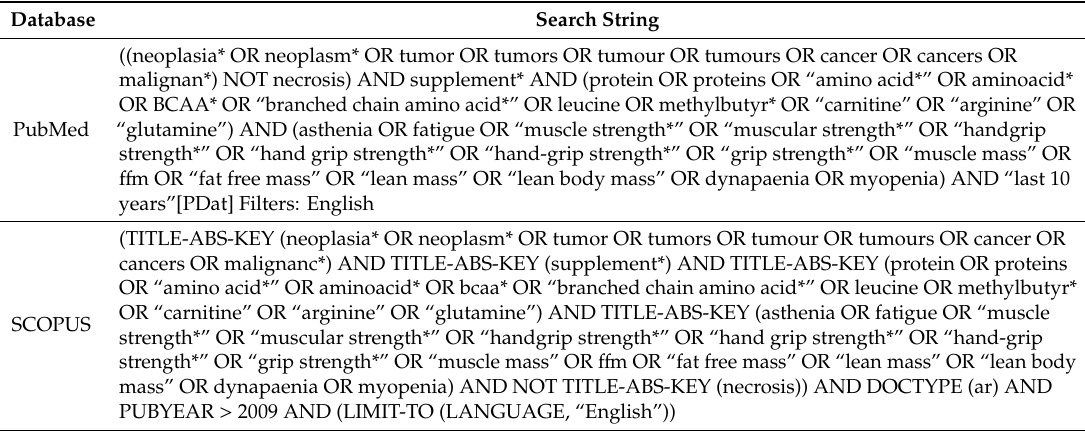
Table 1. Final strings used for searches run in the PubMed and Scopus